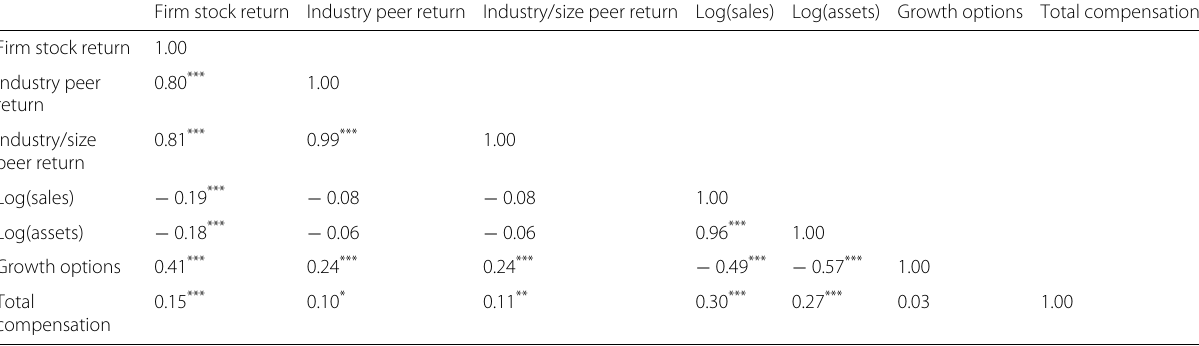
Table 9 Pearson correlation coefficients with value-weighted peer